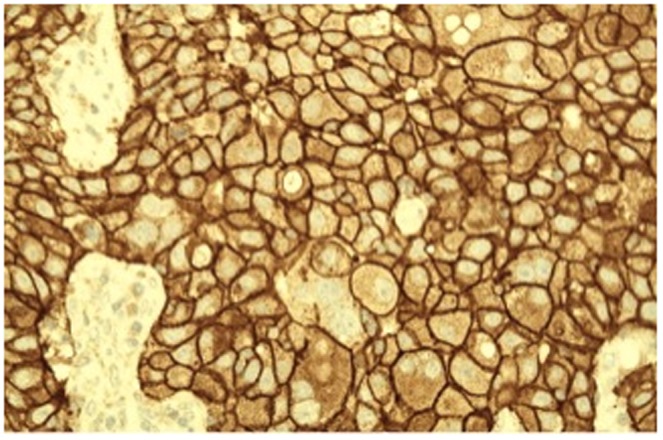
C-erbB2 overexpression shows strong positivity (3+) on the cell membrane by immunohistochemistry (×200 magnification).